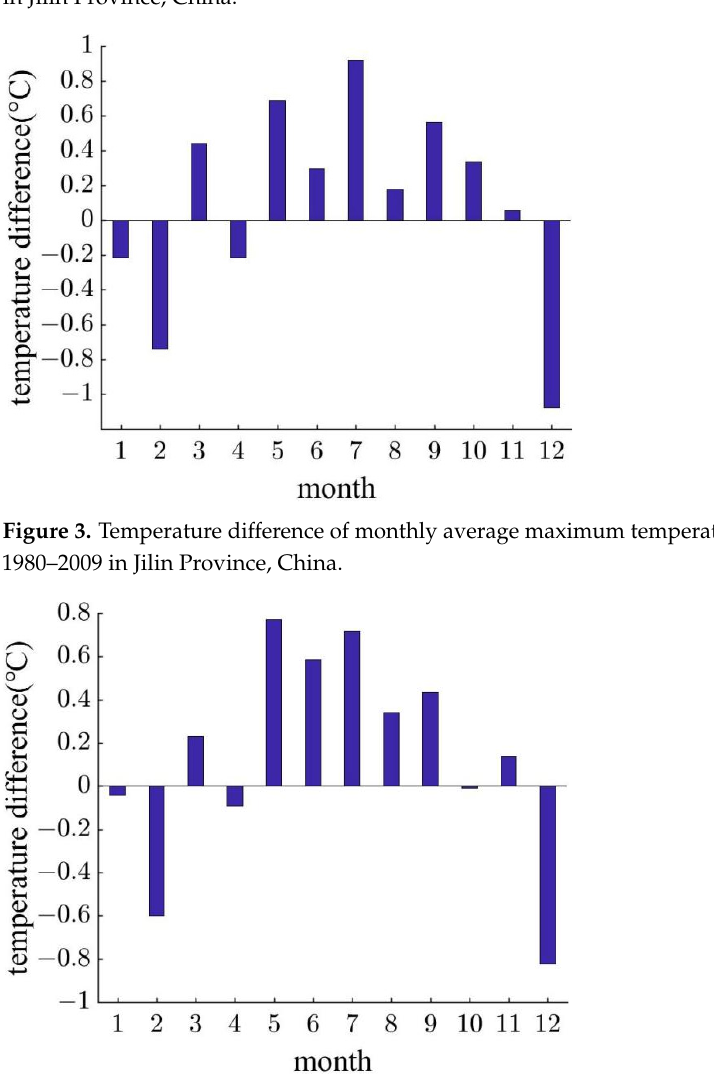
Figure 4. Temperature difference of monthly average minimum temperature between 2010–2019 and 1980–2009 in Jilin Province,